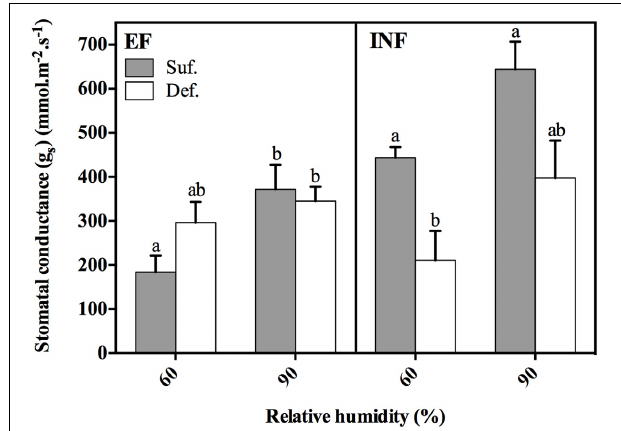
FIGURE 3 | Stomatal conductance (g s ) measured in the 14-day-old unifoliate leaves, 2h 30min after the lights were switched on for each Glycine max ( G. max ) accession (“Fe-efficient,” EF, PI 360952 and “Fe-inefficient,” INF, PI 407707) grown at 60% and 90% relative humidity (RH) under Fe-sufficient (SUF) and Fe-deficient (DEF) conditions. Data are Means ± SEM. Different letters indicate significant differences ( P < 0 . 05) between treatments. Statistical analysis was performed independently for each